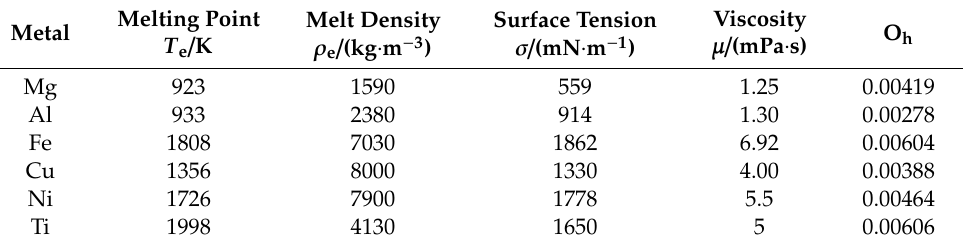
Table 3. Physical properties of metal droplets